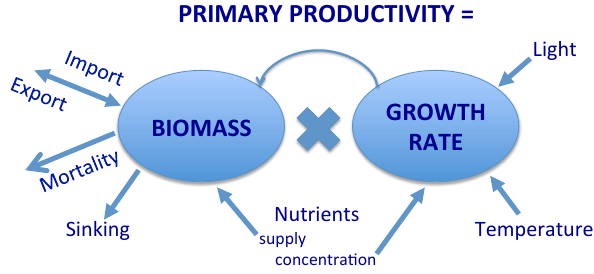
Fig. 6. Primary productivity is the product of phytoplankton biomass (regulated by import, export, sinking, mortality, nutrient supply, and growth rate) times phytoplankton growth rate (regulated by light, temperature, and nutrient